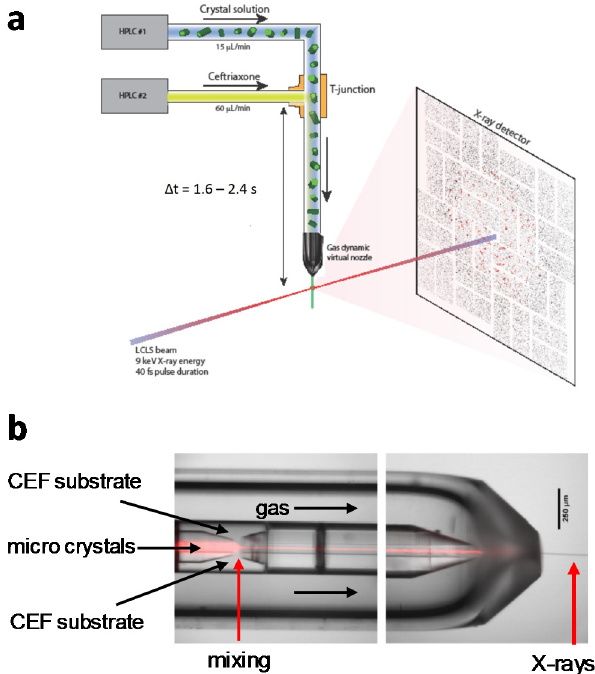
Figure 2. Mixing strategies using liquid jets. ( a ) Mixing with a T-junction outside the nozzle rod. The crystals (green) are mixed with the substrate (Ceftriaxone, yellow). The mixture is injected with a gas dynamic virtual nozzle (GDVN) into the X-ray beam (red). The diffraction pattern is collected on an X-ray sensitive area detector. The time-delays are on a second scale. Figure from Kupitz et al. [38]. ( b ) The optimized mixing device fabricated by the Pollack group. The substrate is mixed with microcrystals (pink) within the nozzle device and quickly injected into the X-ray interaction region. Delays between mixing and injection can be in the sub-millisecond region. This figure is a modified version of the one shown in Calvey et al. [44].